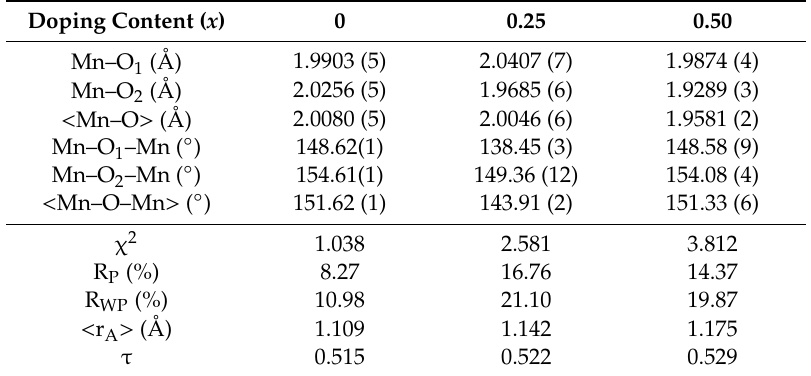
Table 2. Bond length and bond angle between Mn–O–Mn and goodness of fit for Nd 1 − x Bi x MnO 3